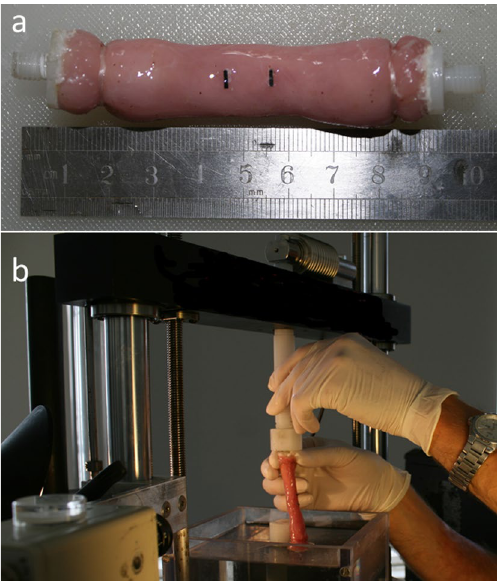
Figure 1. Experimental setup. ( a ) Mid-sections of the esophagus was investigated with gage markers glued for video extensometer detection. ( b ) The ends were secured with yarns to plastic screws for insertion in